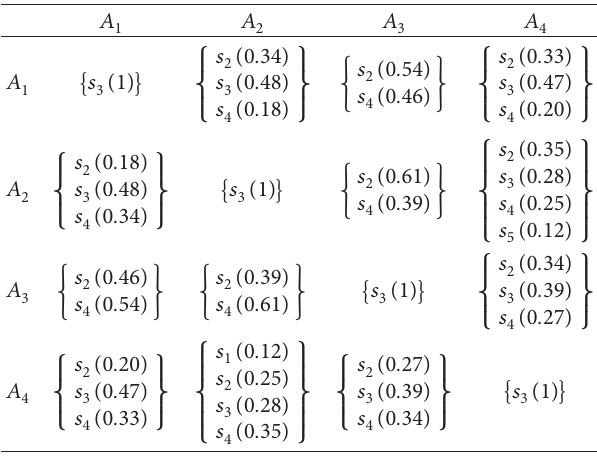
Table 2: The completed hesitant fuzzy probabilistic linguistic preference